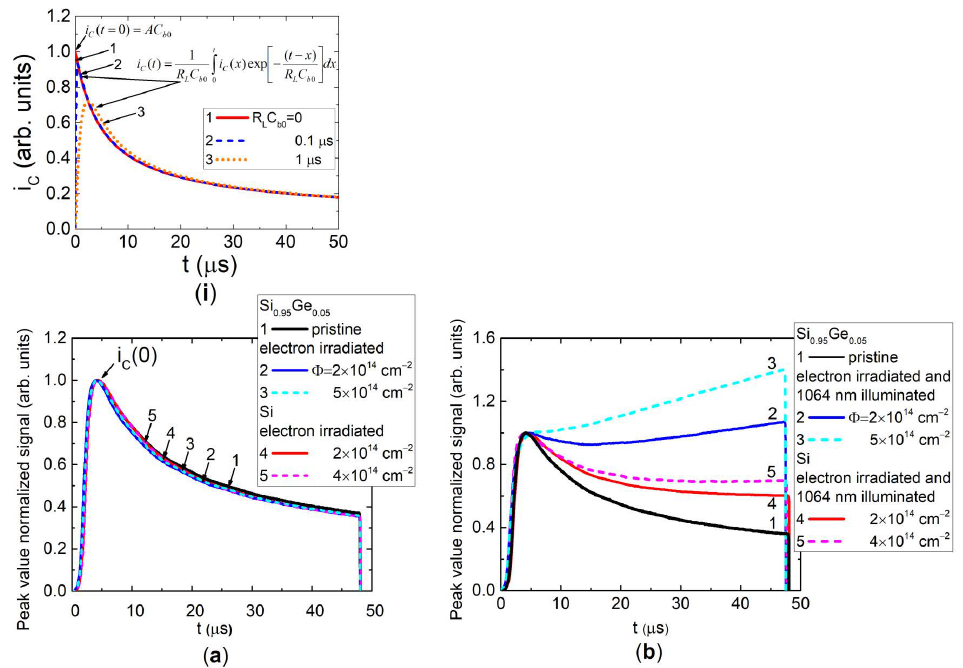
Figure 1. Evolution of BELIV transients in Si as well as Si 0.95 Ge 0.05 diodes irradiated with 5.5 MeV electrons using various fluences and recorded in dark ( a ) as well as under 1064 nm wavelength laser illumination. ( b ) Here, LIV pulses of U P = 12 V and τ PL = 48 µ s were employed. In the inset ( i ), the BELIV pulse components are denoted. Please mark the corresponding serial number in the